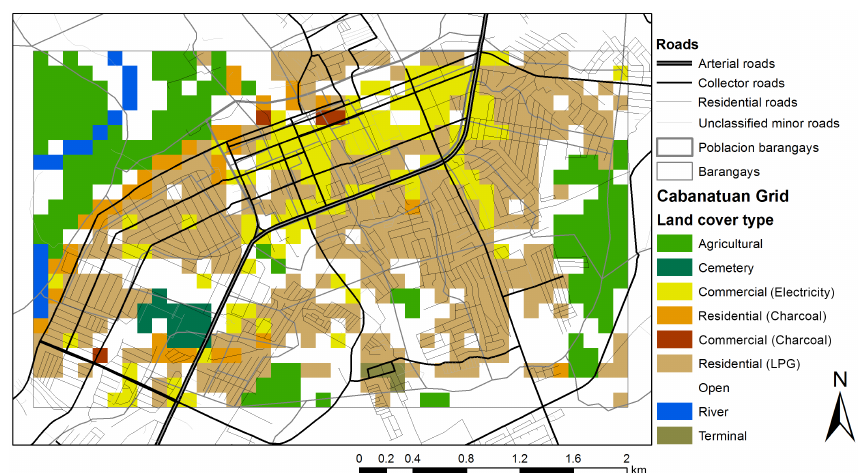
Figure 4. Land cover/land use map from interpretation of satellite image. Base map derived from satellite imagery (Google Earth Pro, 2015, 2016). Additional data from OpenStreetMap (OpenStreetMap contributors,